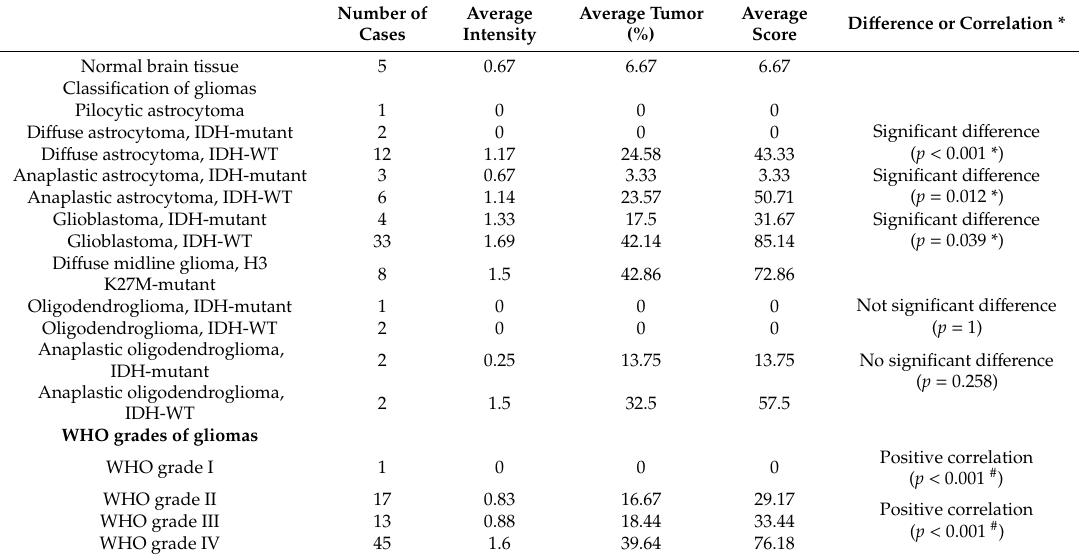
Figure 12. The association between KDELC2 expression with clinicopathologic parameters in human glioma tissues. ( A ) Higher KDELC2 IHC expression correlated with more advanced tumor grades of human glioma tissues. ( B ) Kaplan–Meier survival curve showing that high KDELC2 expression of human gliomas had significantly poor prognosis * p < 0.05. Table 1. The correlation of KDELC2 IHC scores and World Health Organization (WHO) grades of